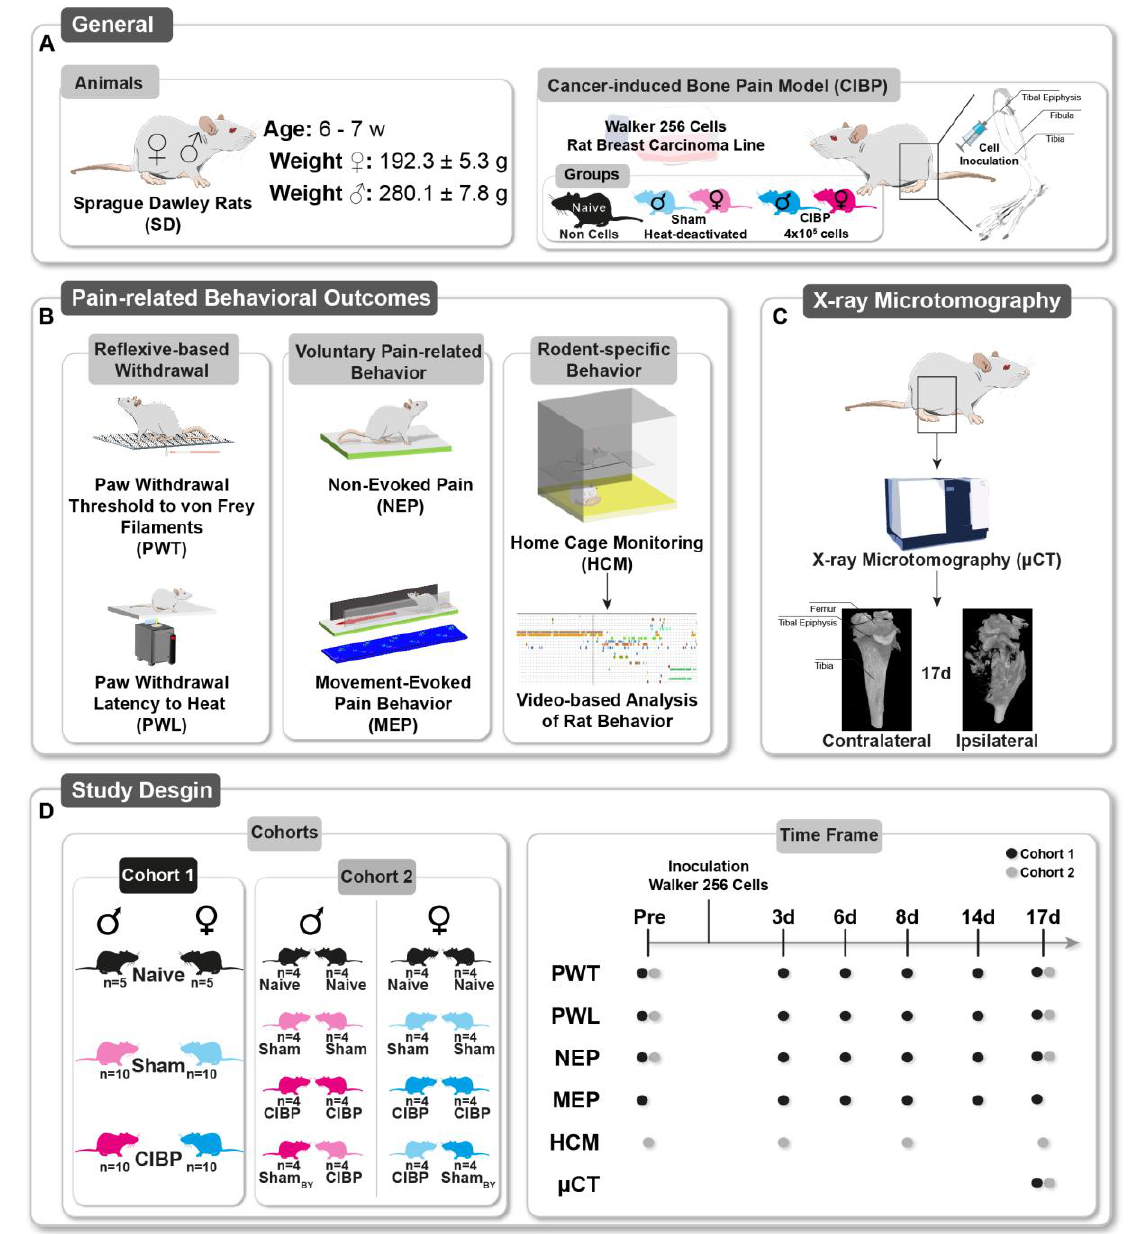
Figure 1. Study design. ( A ) Female and male Sprague Dawley rats (age 6–7 weeks, weight 192.3 ± 5.3 g (mean ± SD), 280.1 ± 7.8 g) were used. This study employed intratibial inoculation ♀ ♂ of Walker 256 cells as a surrogate for cancer-induced bone pain (CIBP). To assess the multimodal CIBP-related behaviors, rats were treated with Walker 256 cells (4 × 10 5 ) or heat-deactivated cells (sham). Naive animals, without any manipulation (anesthesia or cell inoculation), were used to test the effect of intratibial cell injection. ( B ) Multidimensional pain-related behaviors were sub- grouped into reflexive-based withdrawal, including punctate mechanical paw withdrawal threshold (PWT) to mechanical stimuli and paw withdrawal latency (PWL) to heat stimuli; voluntary pain- related behavior, including non-evoked pain (NEP) and movement-evoked pain (MEP) behavior; and rodent-specific behavior assessed by home-cage monitoring (HCM) of the first two night hours. ( C ) Ipsilateral and contralateral tibiae of all rats were examined for bone destruction by X-ray micro- tomography ( µ CT), post-mortem 17 days after cell inoculation. ( D ) Characterizing multidimensional pain behavior trajectories were assessed in a time-dependent manner with cohort 1 in both sexes. HCM was performed with cohort 2 in both sexes and different cagemate